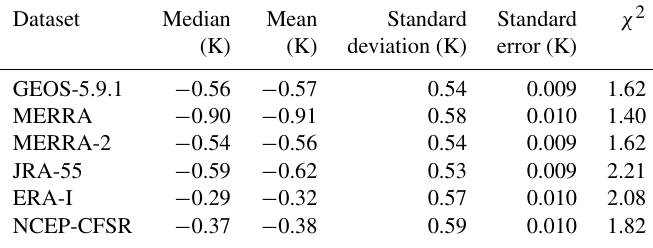
Table 2. Statistics of the reanalysis temperature distributions for LIQ PSCs relative to the theoretical STS equilibrium temperature ( T eq ) at 46hPa for the combined 2008–2013 Antarctic winters (3261 profiles).